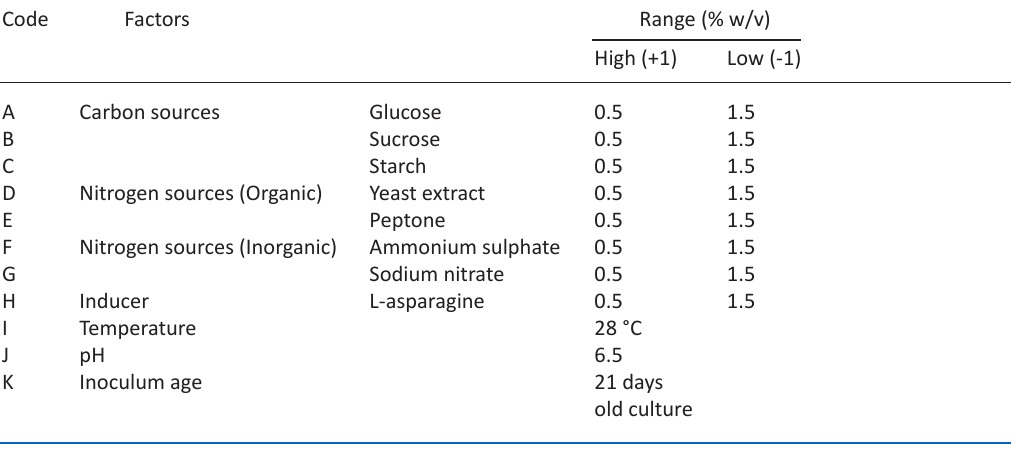
Table 1. Factors and their binary numerical settings in PBD for L-asparaginase production by SmF